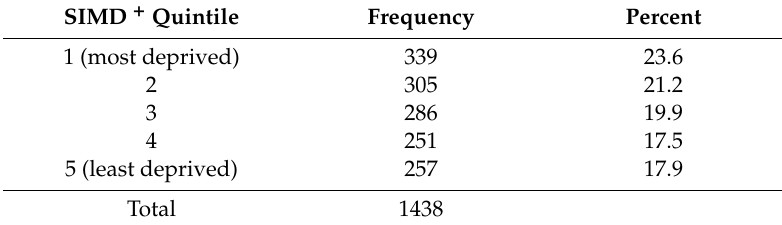
Table 3. Socioeconomic characteristics of participants in routine deliveries of FFIT in Scotland. SIMD +